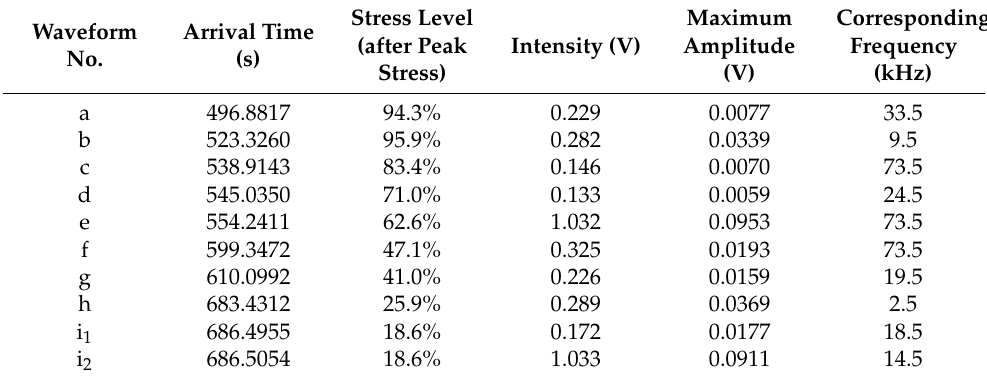
Table 1. Parameters of the EMR waveforms and their time–frequency